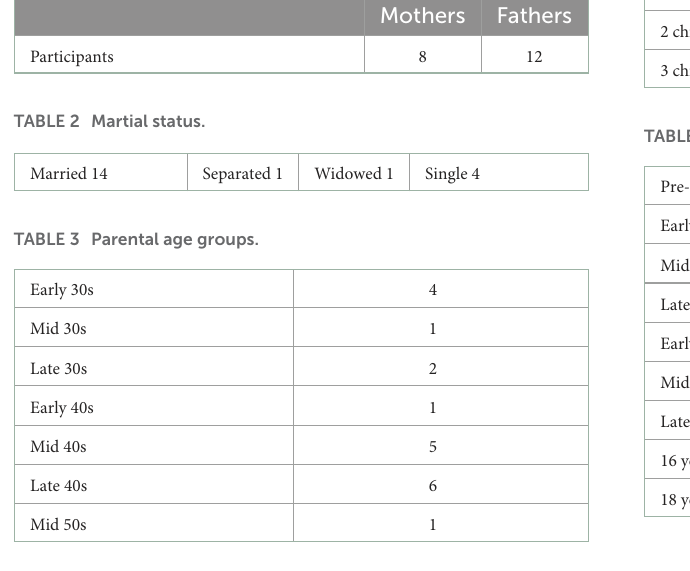
TABLE 4 Minority ethnic background.